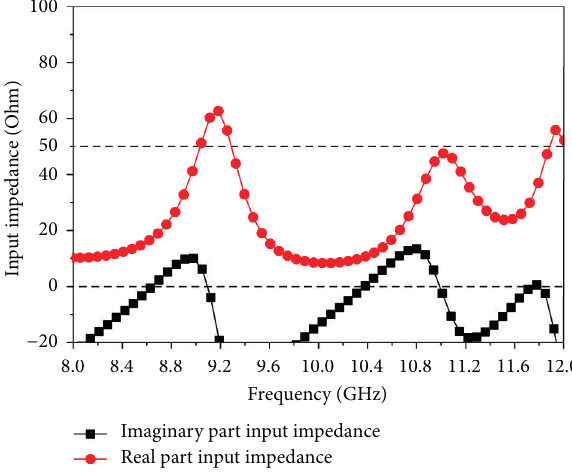
Figure 10: Input impedance of the proposed antenna.